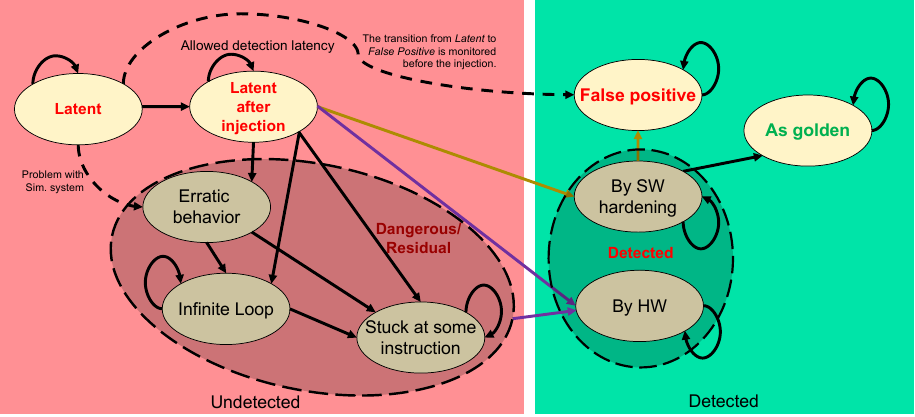
Figure 2. The classifier